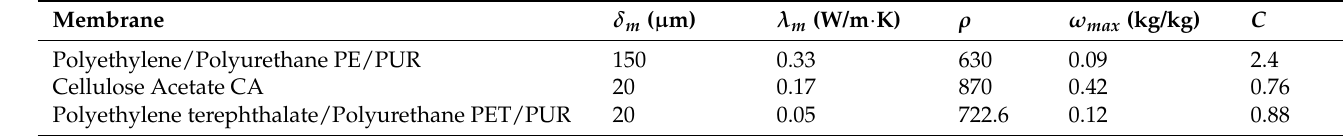
Table 2. Values of membrane